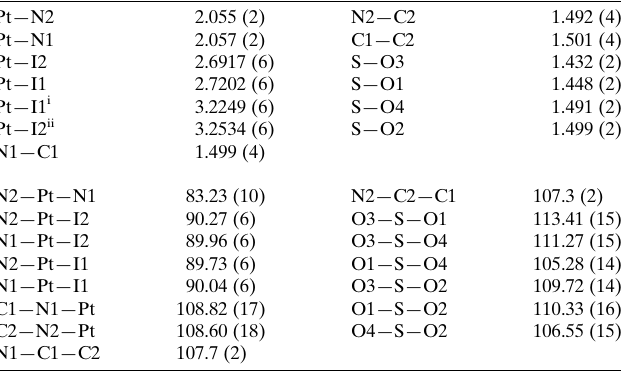
(cid:3) x , y , 1 (cid:3) z 2 2